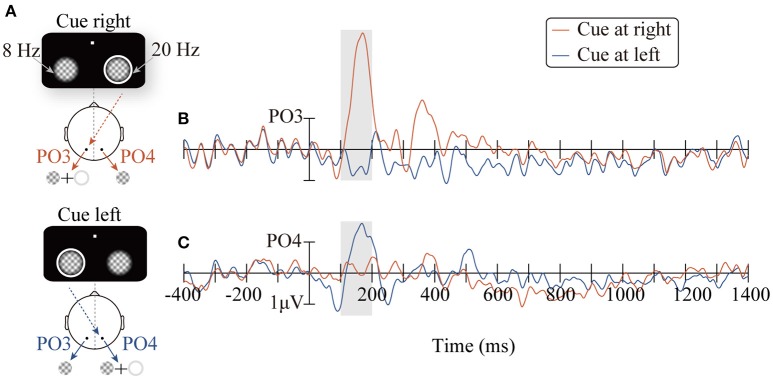
The diagrams of the two conditions: CR and CL for presenting the peripheral cue at the right (red line) and the left location (blue line), respectively (A). ERPs waveforms time-locked to the peripheral cue at the PO3/PO4 electrodes (B,C).